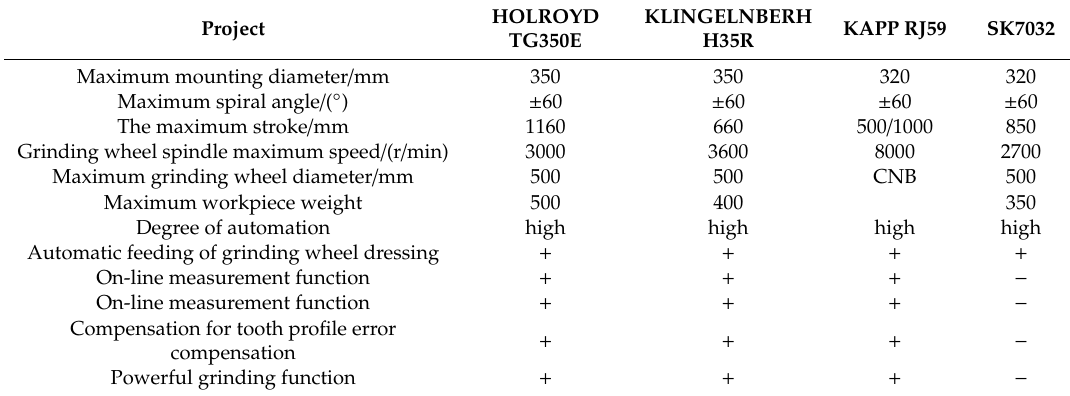
Table 3. Main performance comparison of four Computer Numerical Control (CNC) grinding machines. HOLROYD KLINGELNBERH KAPP RJ59 SK7032 Project TG350E H35R Maximum mounting diameter / mm 350 350 320 320 Maximum spiral angle / ( ◦ ) ± 60 ± 60 ± 60 ± 60 The maximum stroke / mm 1160 660 500 / 1000